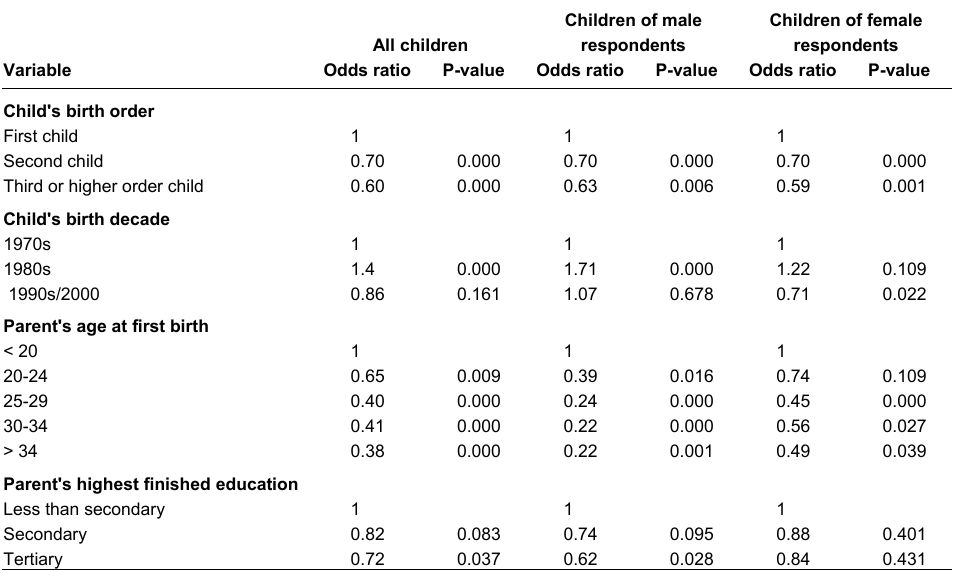
Table 4 : Relative odds of child not living with both biological